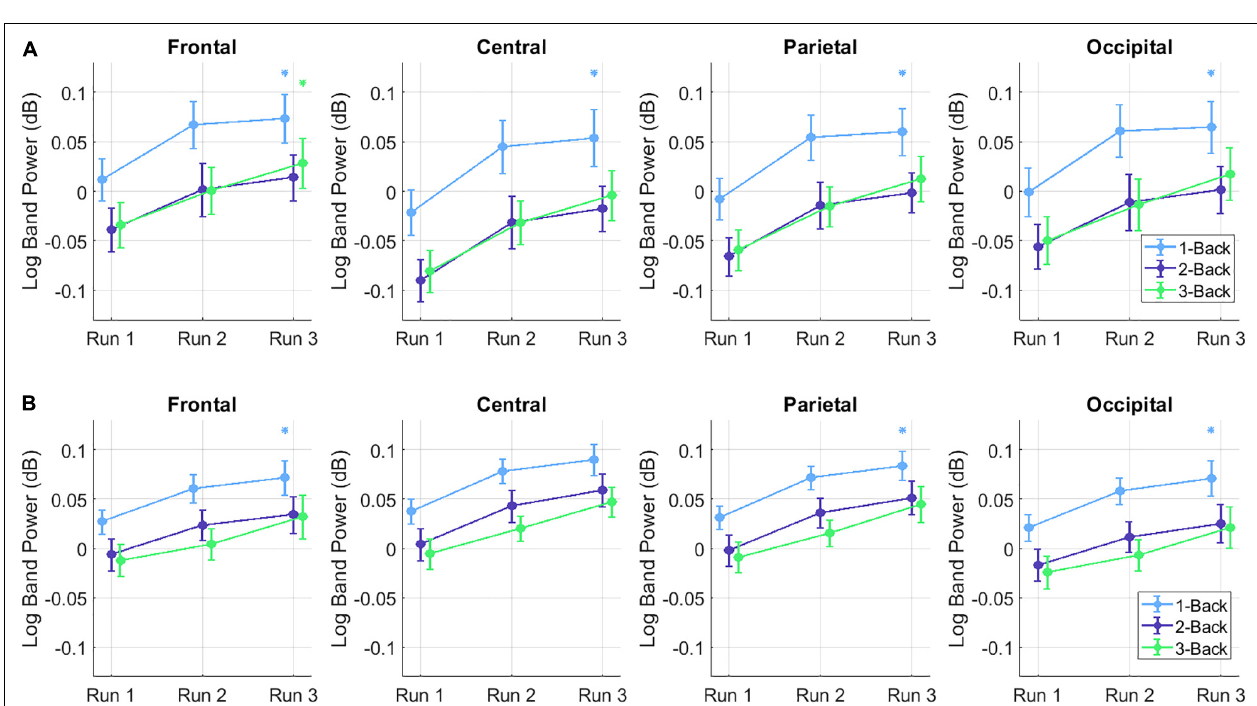
FIGURE 4 | Grand average theta BP changes of the (A) high PG and (B) low PG. The task conditions were averaged over all trials at each run.